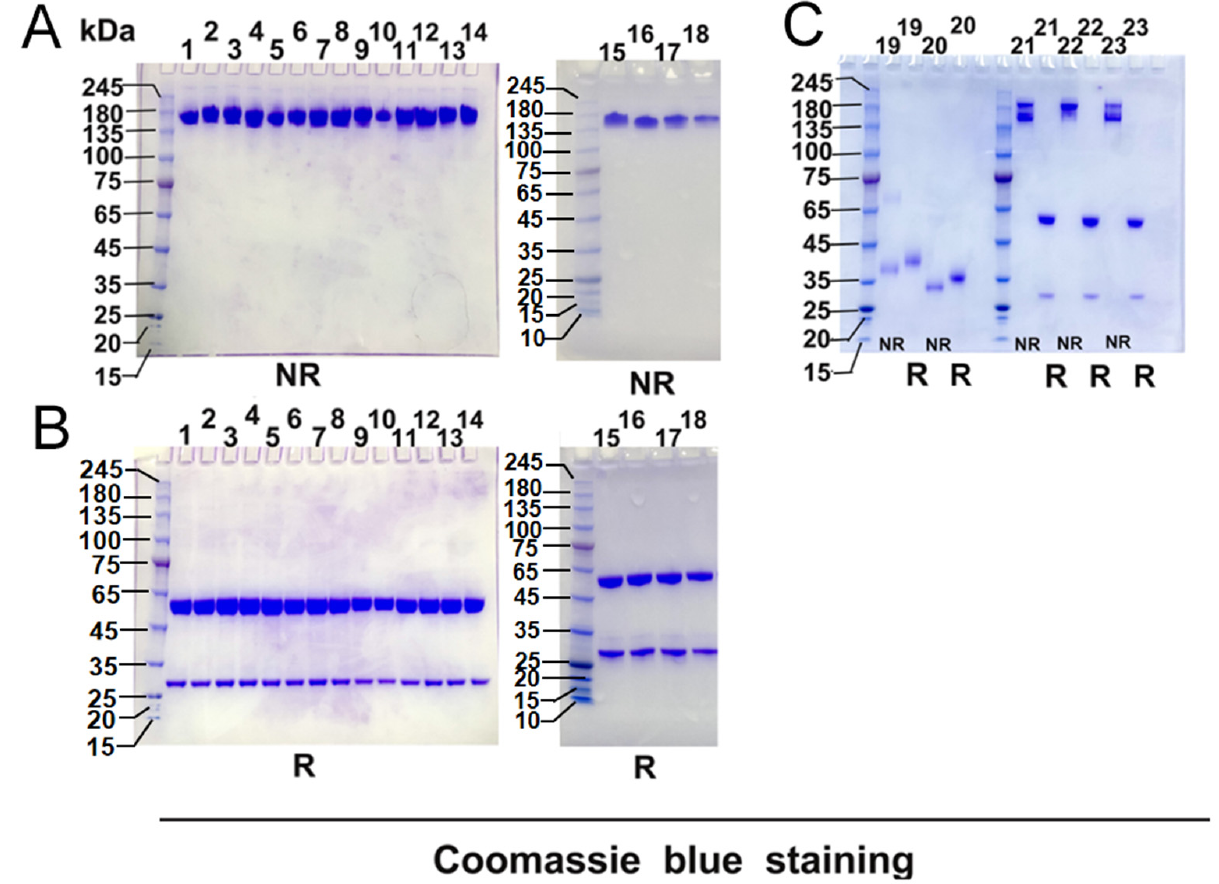
Figure 2. Recombinant CR3022 antibody, CR3022 variants and RBD analyzed by SDS-PAGE. All proteins were fractionated 4–12% Bis-Tris SDS-PAGE under both non-reduced and reduced conditions. Gels were stained with Coomassie blue dye. All antibodies and RBD protein migrated in the gels as a single protein band with an apparent MW of 160 kDa(antibody) or 30–38 kDa(RBD) under non-reduced condition (NR) ( A ) and as 2 protein bands with apparent MWs of 50 kDa and 30 kDa under reduced conditions (R) ( B , C ). The sample information of ( A ) 1–18 lanes were non-reduced of G28W, T31F, T31Y, S103R, S103I, S103F, S103W, S103Y, S33R, S33H, S33I, S33L, S33K, S33M, S33F, S33W, S33Y, N35Y. The sample information of ( B ) 1–18 lanes were reduced of G28W, T31F, T31Y, S103R, S103I, S103F, S103W, S103Y, S33R, S33H, S33I, S33L, S33K, S33M, S33F, S33W, S33Y, N35Y. The sample information of ( C ) 19–23 lanes were non-reduced and reduced of SARS-CoV RBD, SARS-CoV-2 RBD, CR3022, S103F(H)–S33R(L) and S103Y(H)–S33R(L), respectively. The binding of the wild-type and variants of CR3022 antibody to the SARS-CoV-2 RBD and SARS-CoV RBD were respectively evaluated by ELISA assays. As shown in Figure 3, the wild-type CR3022 antibody and its single-site mutants could bind tightly to the SARS-CoV RBD and SARS-CoV-2 RBD. Herein, the ELISA results obviously showed that the single-site modification of the CR3022 antibody could not affect its biological function of binding to the SARS-CoV RBD and SARS-CoV-2 RBD, despite the binding affinity of three mutants (S33F, S33W and S33L) to SARS-CoV-2 RBD being slightly reduced. Similarly, the biological activity of the double-site modification of the CR3022 antibody has not been changed